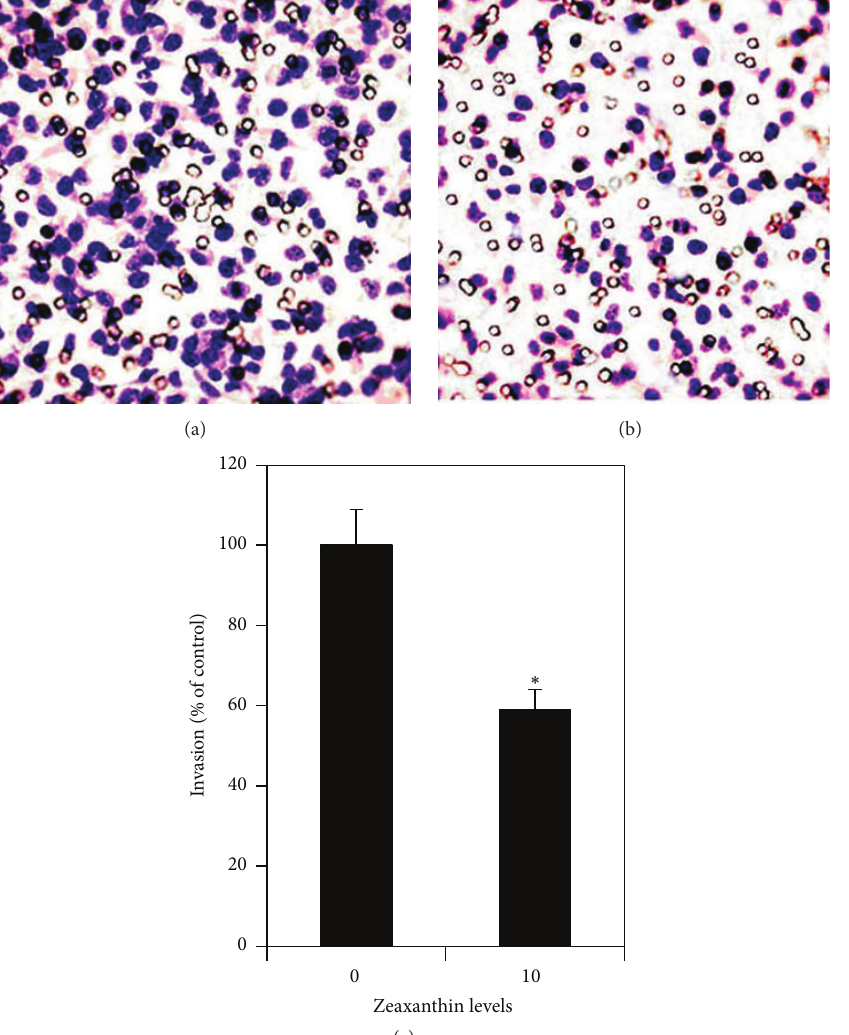
Figure 4: Zeaxanthin inhibits invasion of UM cells by using Matrigel invasion assay. Cells (C918) were seeded into the Matrigel Invasion Chamber and placed into a 24-well plate with DMEM supplemented with 10% serum. After being cultured with (b) or without (a) zeaxanthin at 10 𝜇 M for 16h, the invasion of UM cells was measured by counting the invading cells on the lower surface of the filter membrane at 10 fields. Numbers of invading cells in cultures without zeaxanthin and with zeaxanthin were 231.9 ± 20.4 and 135.8 ± 12.2 cells (mean ± SD), respectively, and expressed at the bar graph as 1.00 ± 0.09 and 0.59 ± 0.05 (percentages of the control), respectively. Photos were taken by a light microscope at × 200. Zeaxanthin significantly inhibited the invasion of UM cells ( 𝑛 = 3 , 𝑃 < 0.05 ) (c). ∗ 𝑃 < 0.05 , versus control (cells cultured without